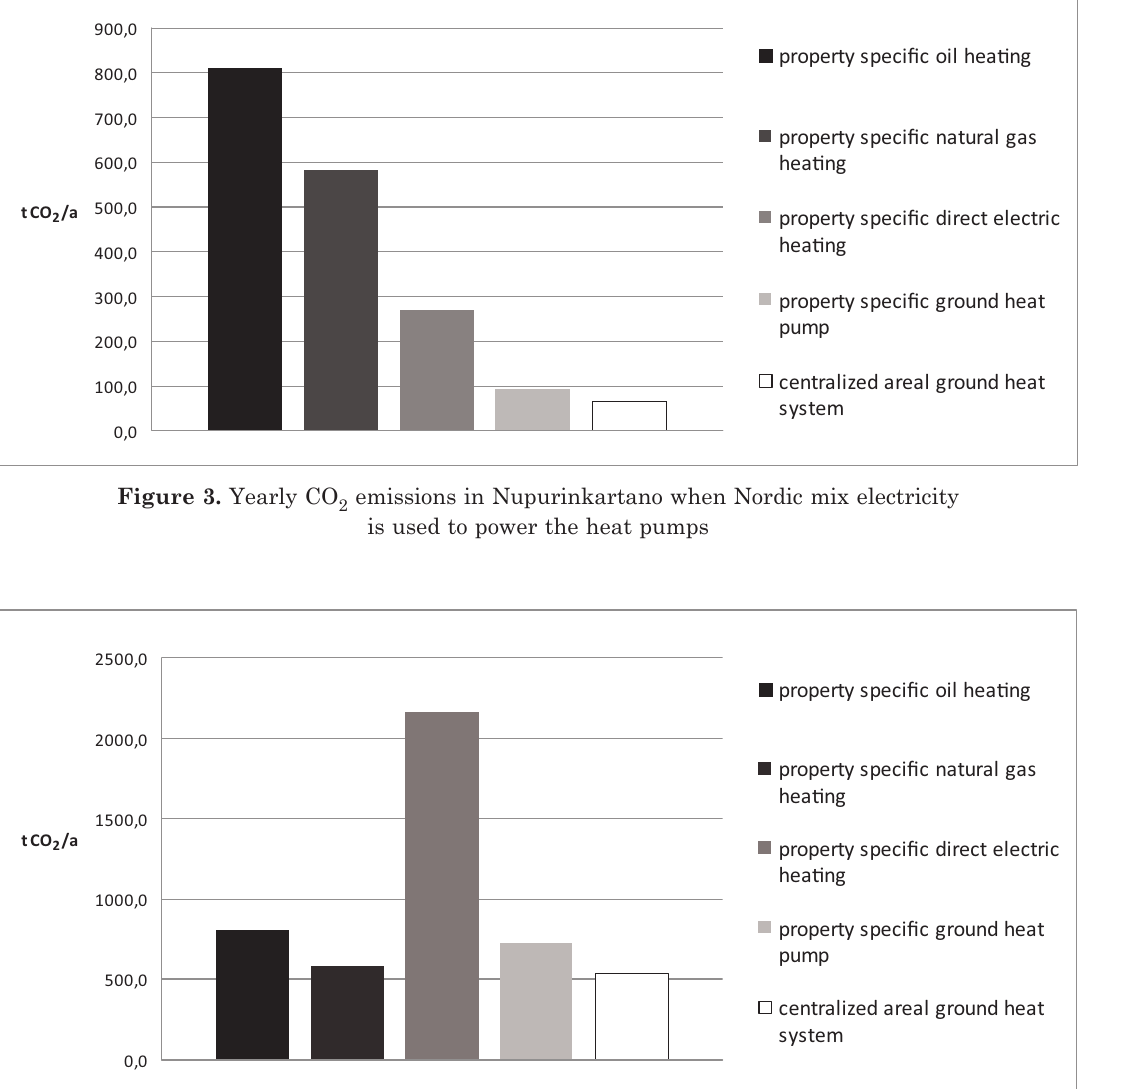
emissions in Nupurinkartano when coal condensate electricity Figure 4. Yearly co 2 is used to power the heat